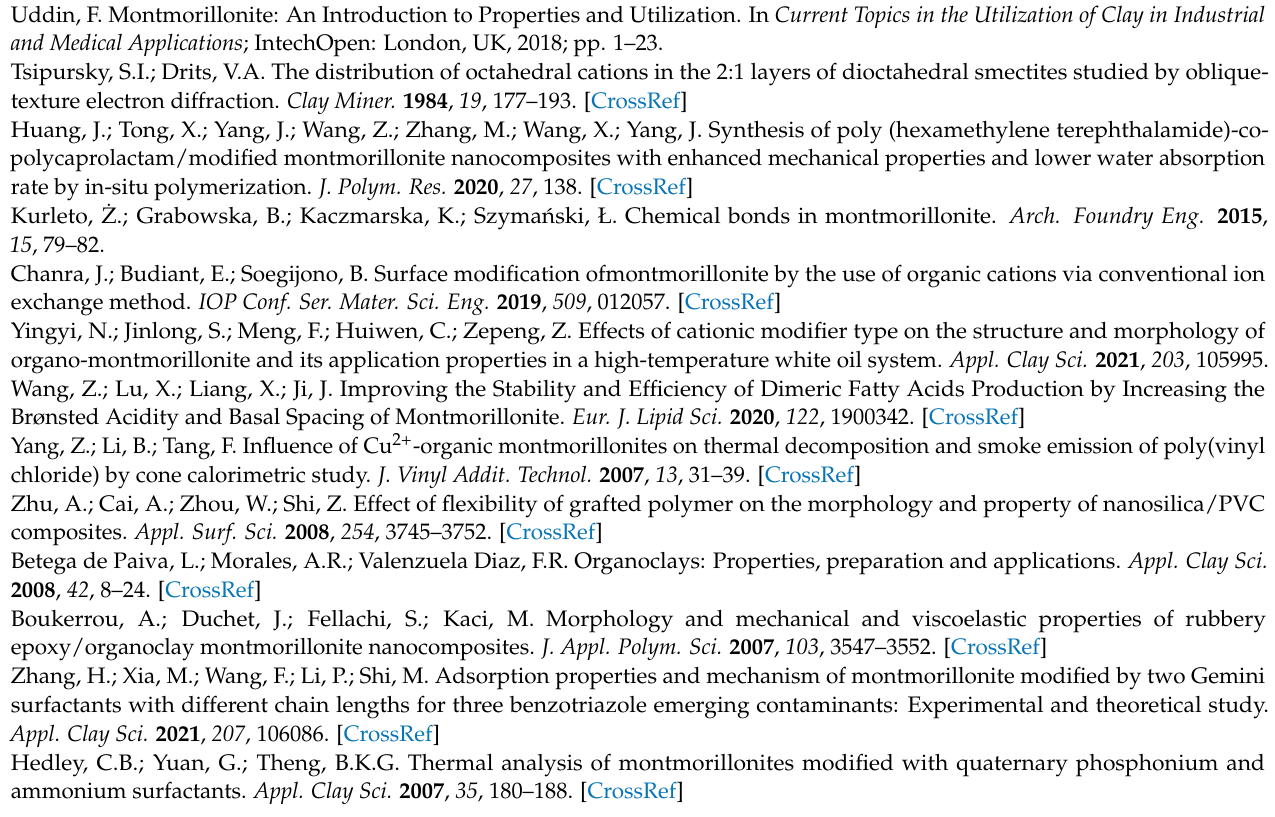
Figure S5: Flow chart of the procedure applied during the modification of montmorillonite